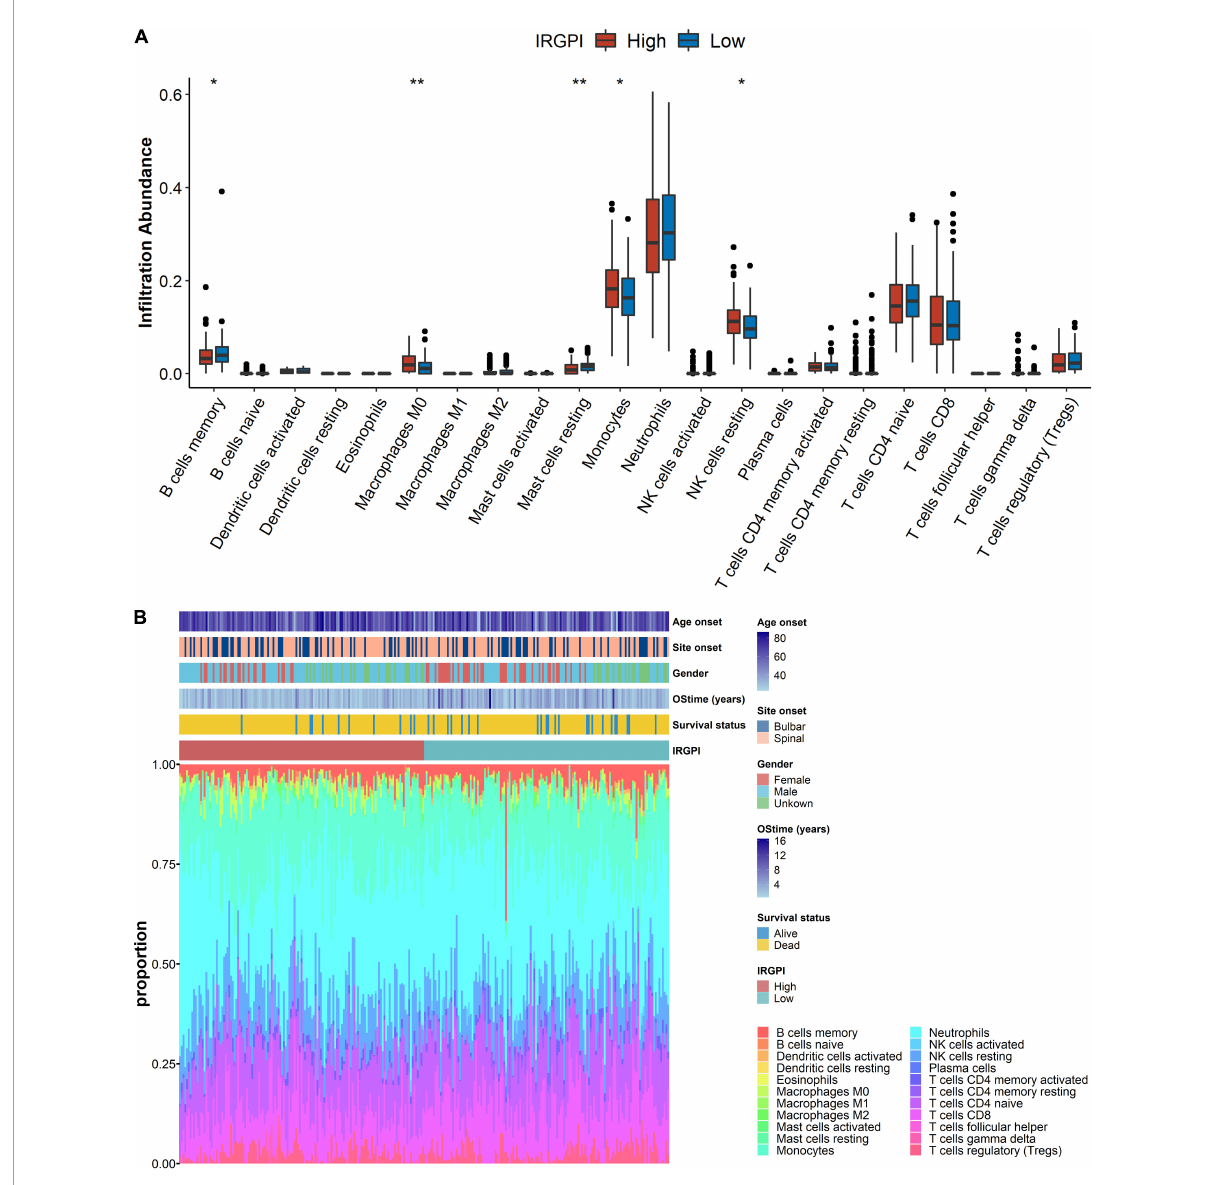
FIGURE6 The landscape of the immune microenvironment in ALS and the characteristics of different immune-related gene prognostic index (IRGPI) subtypes. (A) The proportions of immune cells between different IRGPI subtypes Wilcoxon test (* p < 0.05, ** p < 0.01). (B) The IRGPI subtypes and proportions of immune cells for 397 amyotrophic lateral sclerosis (ALS) patients. Age onset, site onset, gender, OStime, and survival status are shown as patient annotations.